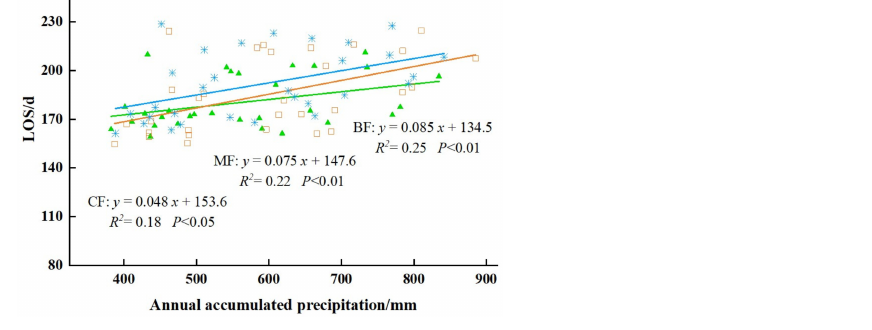
Figure 18. Responses of phenology to precipitation of different forest types in northeast China from 2011 to 2020. ( A ) SOS of different forest types; ( B ) EOS of different forest types; ( C ) LOS of different forest types.